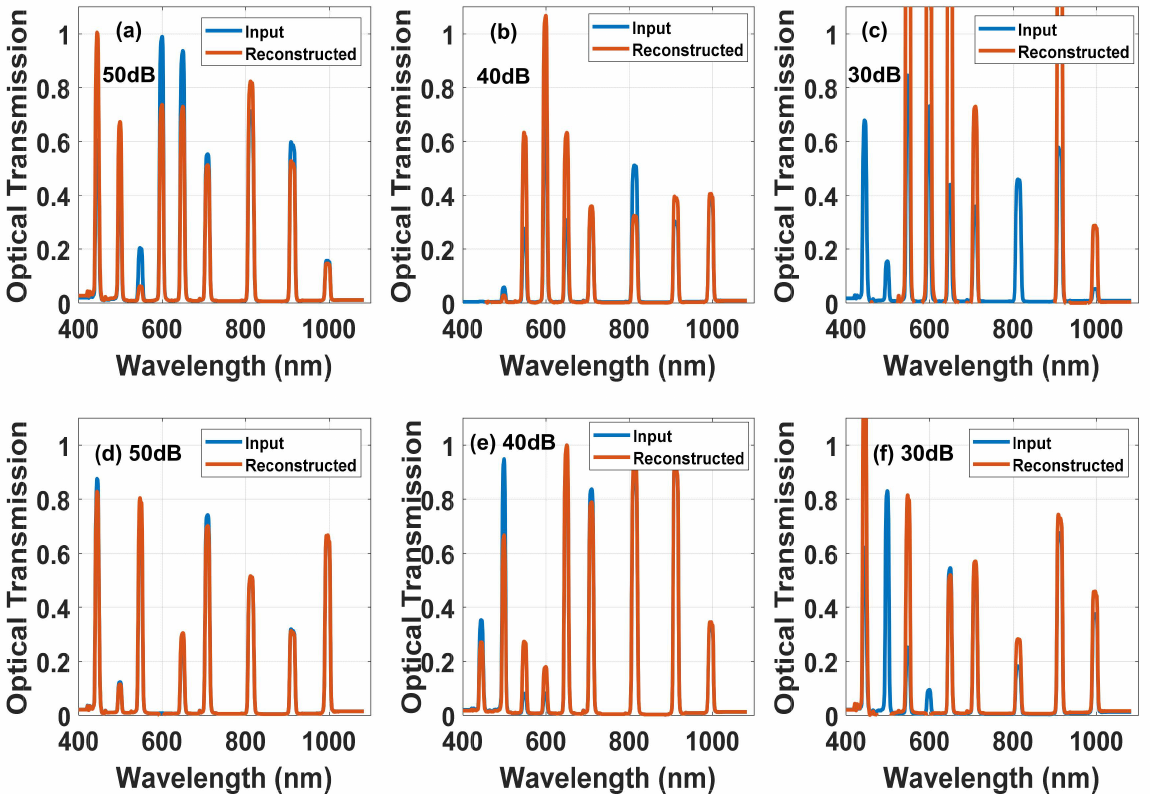
Figure 15. Simulated reconstructed spectra with the input signal is the blue curve and the red is the reconstructed ones using two different DHFLC-618 gaps, 110 µ m for ( a – c ) while 153 µ m for ( d – f ) and different SNR values in dB: ( a , d ) 50; ( b , e ) 40; ( c , f ) 30. The number of voltages is 51.